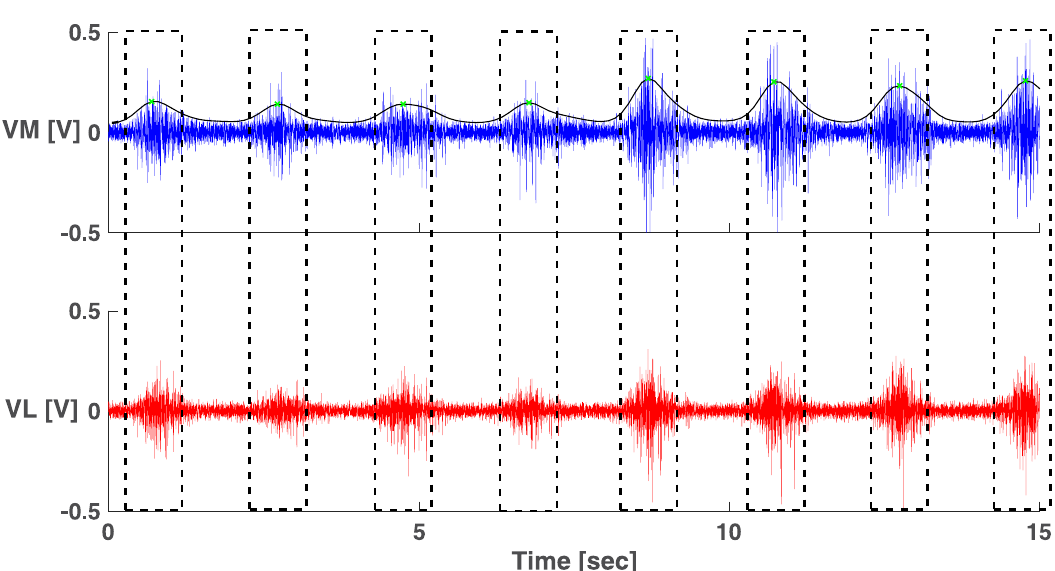
Fig 5. 60 Hz filtered VM EMG with wavelet filter envelope (top), and 60 Hz filtered VL EMG (bottom). Traces show EMG data from one subject. Envelope output of the wavelet filter (black trace), midpoints (green dots), and windows (dashed boxes) used for coherence calculation are also shown.